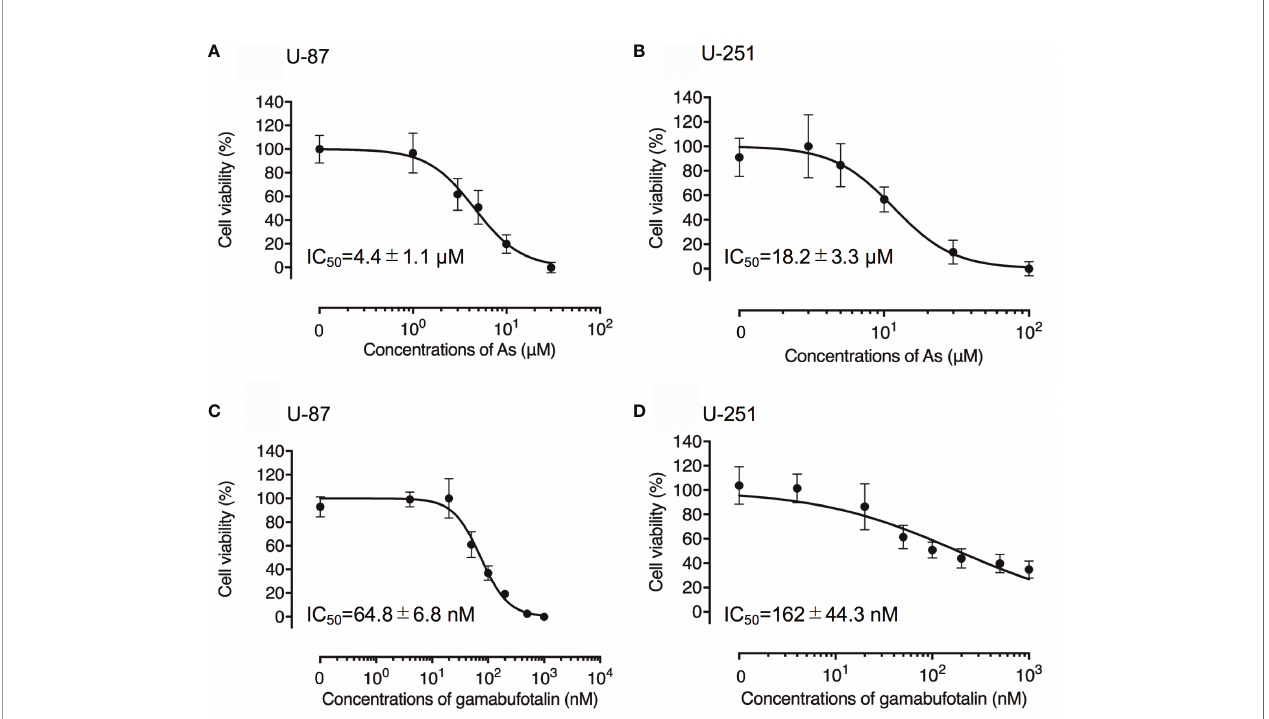
FIGURE 1 | Respective cytotoxic effect of As III and gamabufotalin against human glioblastoma cell lines U-87 and U-251. Cell viability was determined by XTT assay after the treatment with various concentrations of As III alone [(1, 3, 5, 10, and 30 µM) (A) ; (3, 5, 10, 30 and 100 µM) (B) ], gamabufotalin alone [4, 20, 50, 100, 200, 500, and 1,000 nM (C, D) ] for 48 h. Relative cell viability was calculated as the ratio of the absorbance at 450 nm of each treatment group against those of the corresponding untreated control group. Data are shown as the means ± SD (n ≥ 3). As, As III